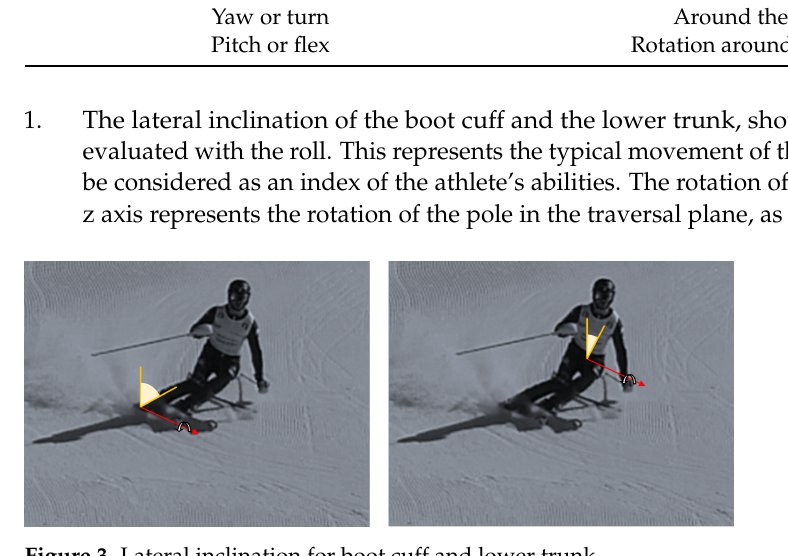
Figure 3. Lateral inclination for boot cuff and lower